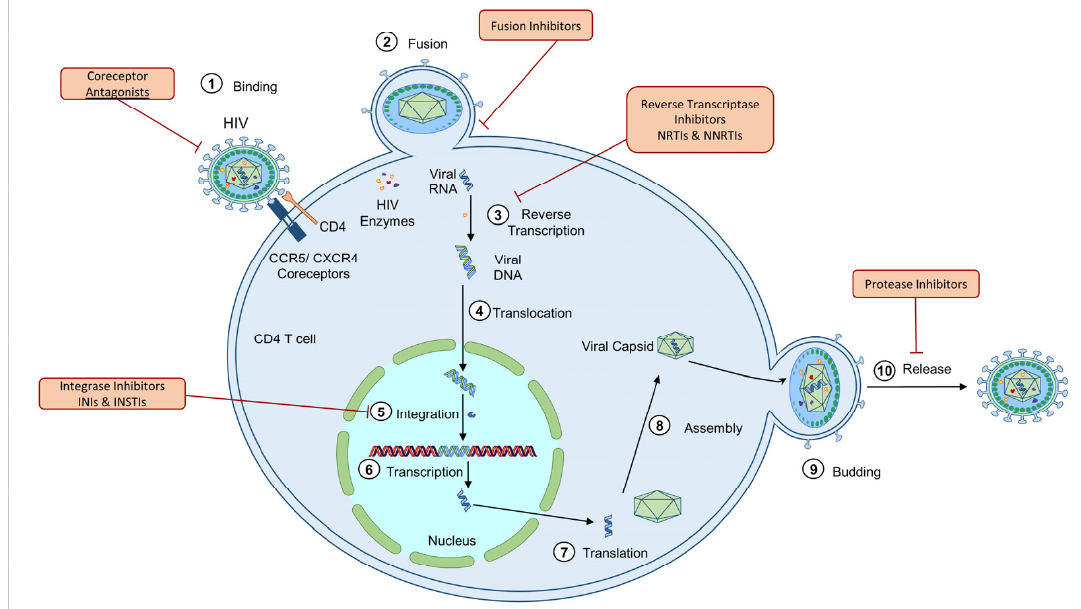
Figure 1. The viral lifecycle of human immunodeficiency virus HIV-1 infection and steps of antiretroviral therapy (ART) interference. HIV infection begins by glycoproteins, such as Env/gp120, on the surface of the HIV virus interacting with CD4 and CCR5/CXCR4 receptors on the surface of a target CD4 T cell (step 1), which is inhibited by coreceptor antagonists. This facilitates fusion between the HIV membrane and the cell membrane (step 2). This step is inhibited by fusion inhibitors. The viral capsids containing HIV enzymes and viral RNA are released into the cell cytoplasm, followed by reverse transcription of the viral RNA into DNA by HIV reverse transcriptase (step 3), which is inhibited by nucleoside-analog and non-nucleoside reverse transcriptase inhibitors (NRTIs and NNRTIs). The viral DNA is then transported into the cell nucleus for integration into the host genome by HIV integrase and transcription (steps 5 and 6). Integrase inhibitors, including INIs and INSTIs, prevent the integration step. The transcribed DNA is then released into the cytoplasm for translation via Rev-mediated export (step 7) and assembly into the viral capsid (step 8) for budding (step 9) and release (step 10), following which HIV protease cleaves polyproteins to create an active virus capable of infecting new cells. Protease inhibitors prevent the final release of a functional replicating